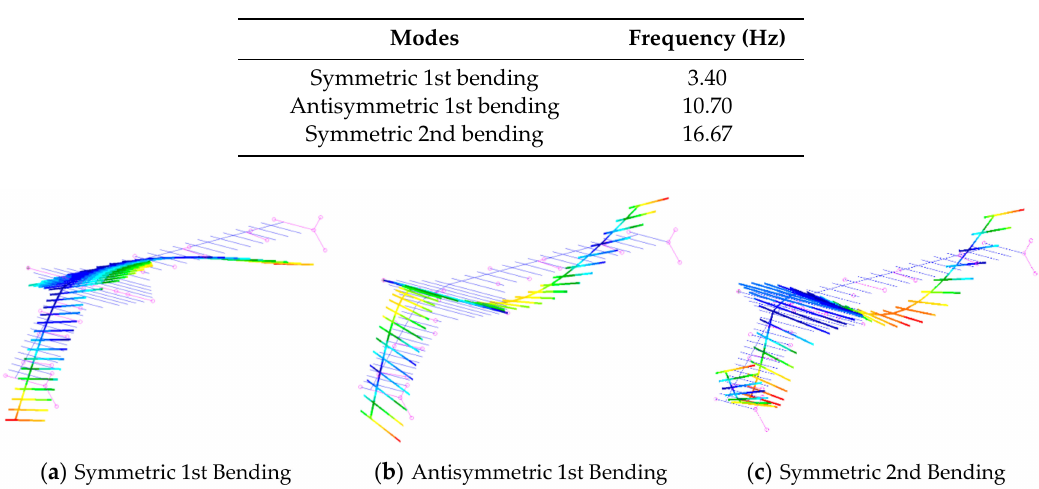
Table 2. First three elastic modal frequencies of BFF wind tunnel test on the UAV.